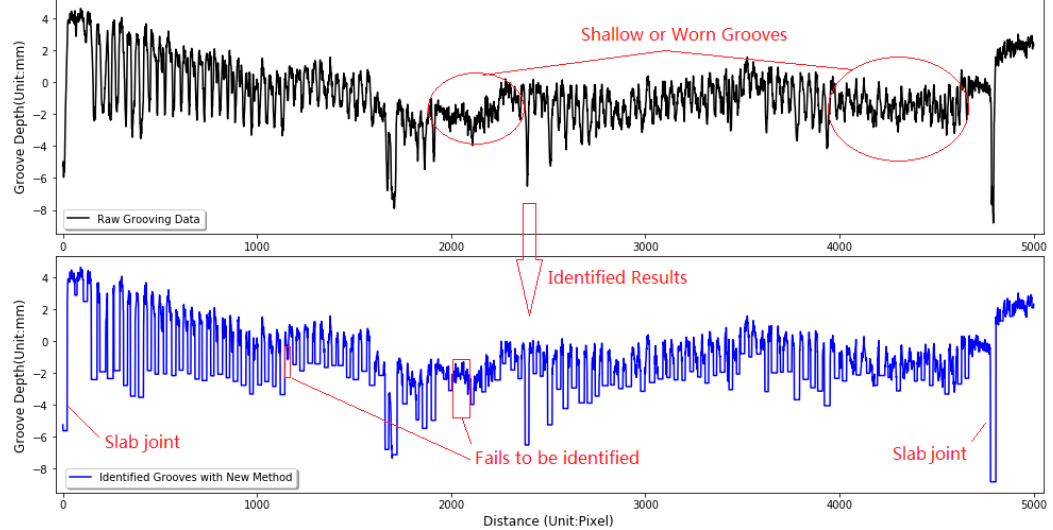
Figure 13. Plots of the severely worn grooves on slab 17 and their identification results.